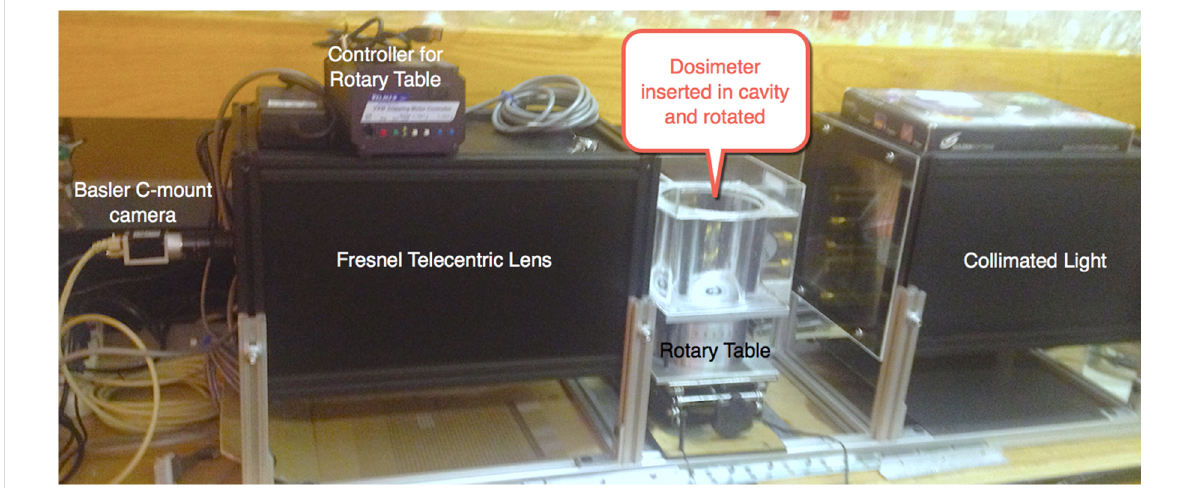
Figure 5: OCT scanner used in our lab to create 3D images.